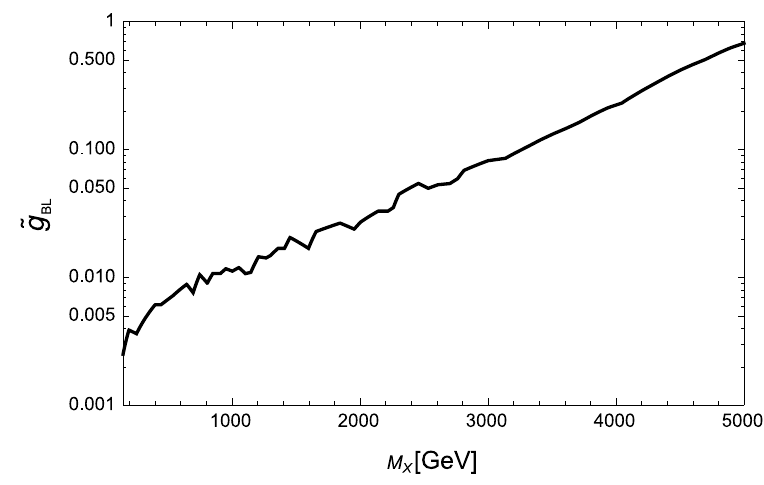
Figure 1 . The ATLAS bound on the effective coupling ˜ g BL as a function of M X from figure 5 in ref.